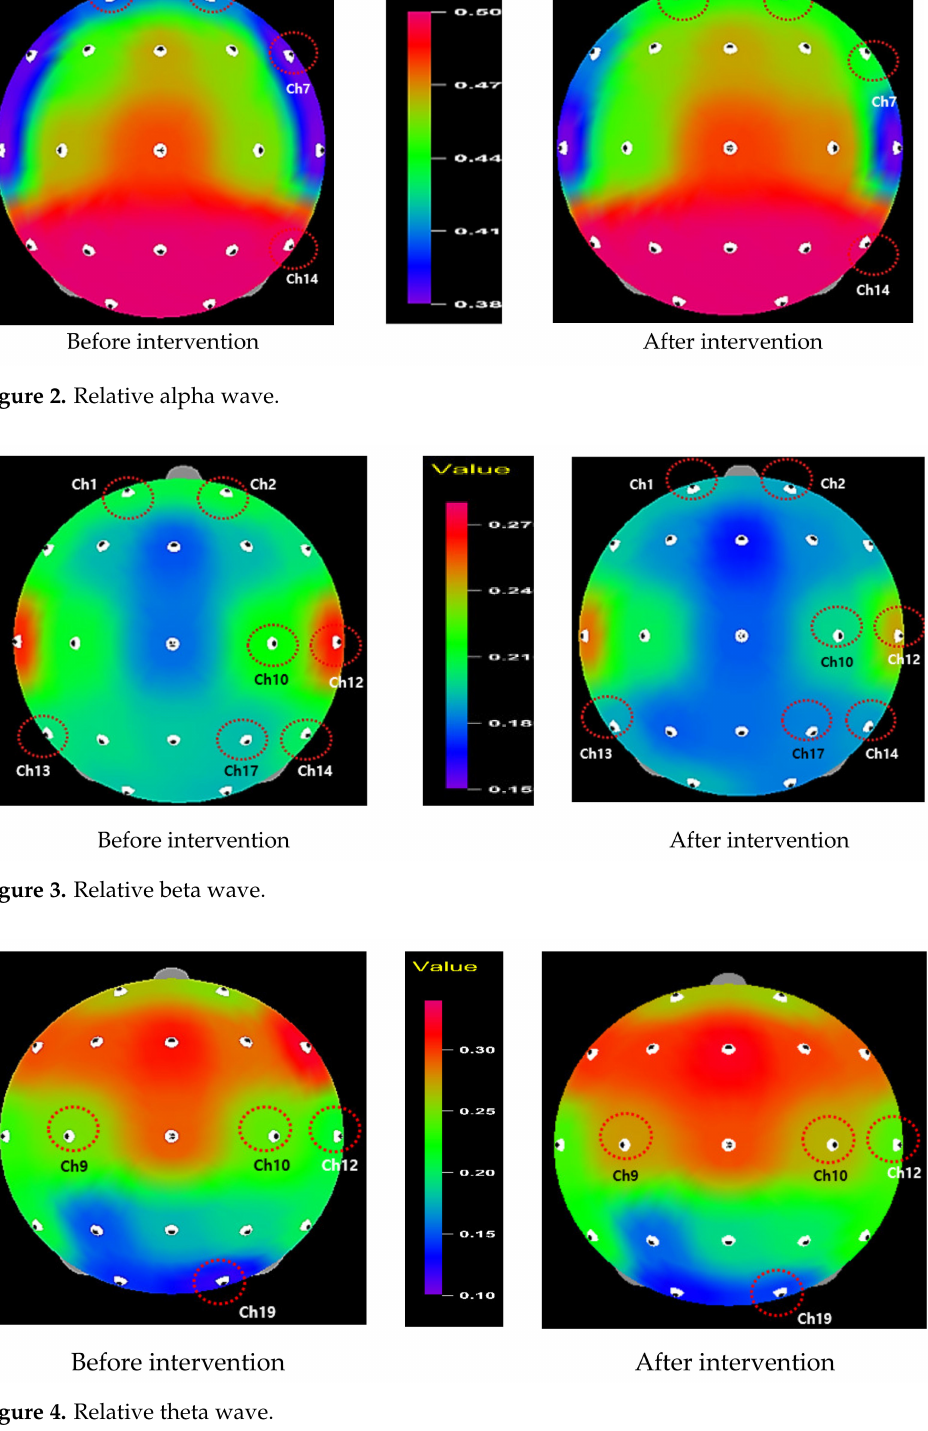
Figure 4. Relative theta